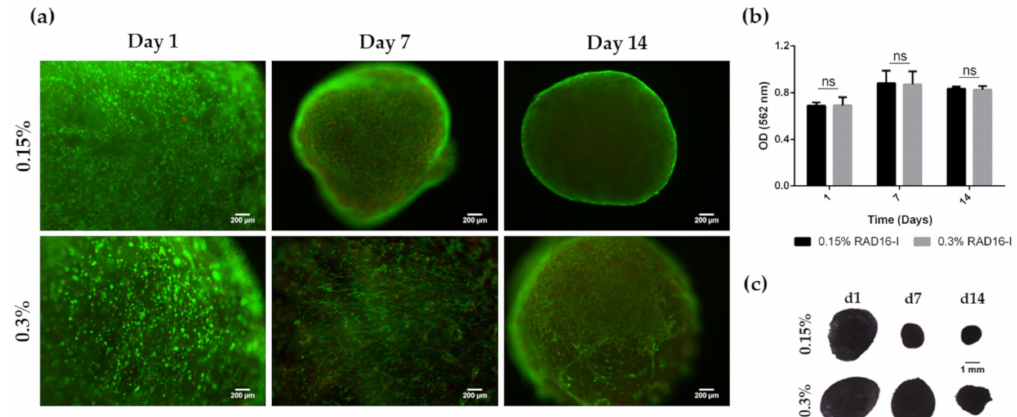
Figure 3. Viability of HFDPC cultured in the 3D self-assembling peptide sca ff old RAD16-I at 0.15% and 0.3% peptide concentration. ( a ) Fluorescent images of Live / Dead staining. Scale bar: 200 µ m; ( b )